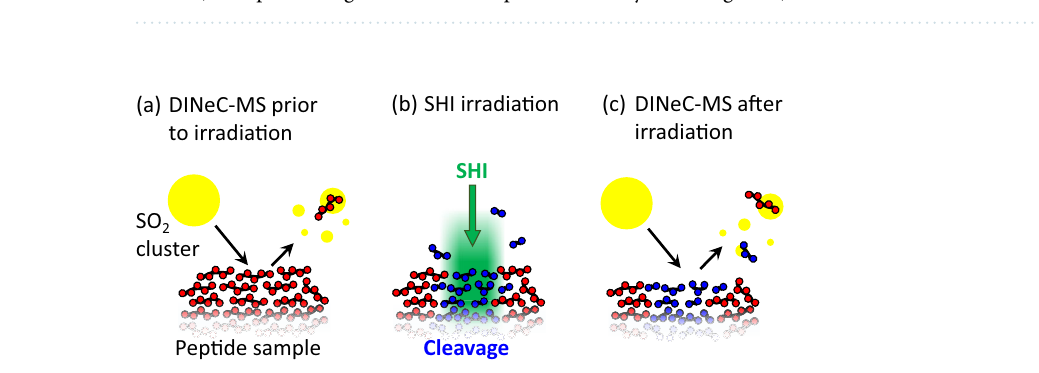
Figure 1. Irradiation of oligopeptide films with swift heavy ions leads to fragmentation of the sample molecules in the vicinity of the ion trajectory (schematic on the left, image not to scale, ion track diameter in the range of some ten nanometers, see below). This SHI-induced fragmentation may either involve the bonds of the peptide backbone (specific fragmentation, examples indicated by blue lines) or arbitrary bonds of the amino acid side chains (non-specific fragmentation, example indicated by the orange line).